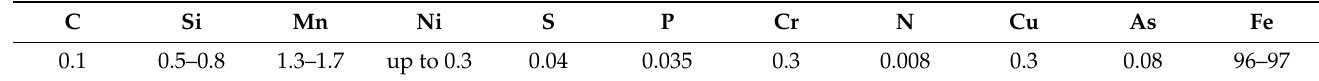
Table 1. Chemical composition of steel A516-55